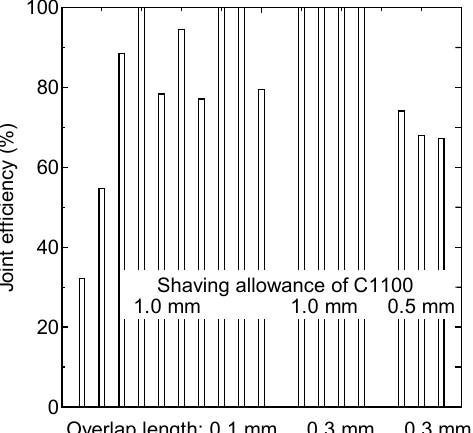
Figure 16. Joint efficiency of joining using shaved surface under various experimental conditions.